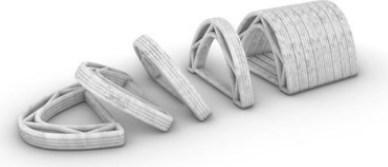
Figure 11. The concept design of the extruded vault (Image credit: Authors).